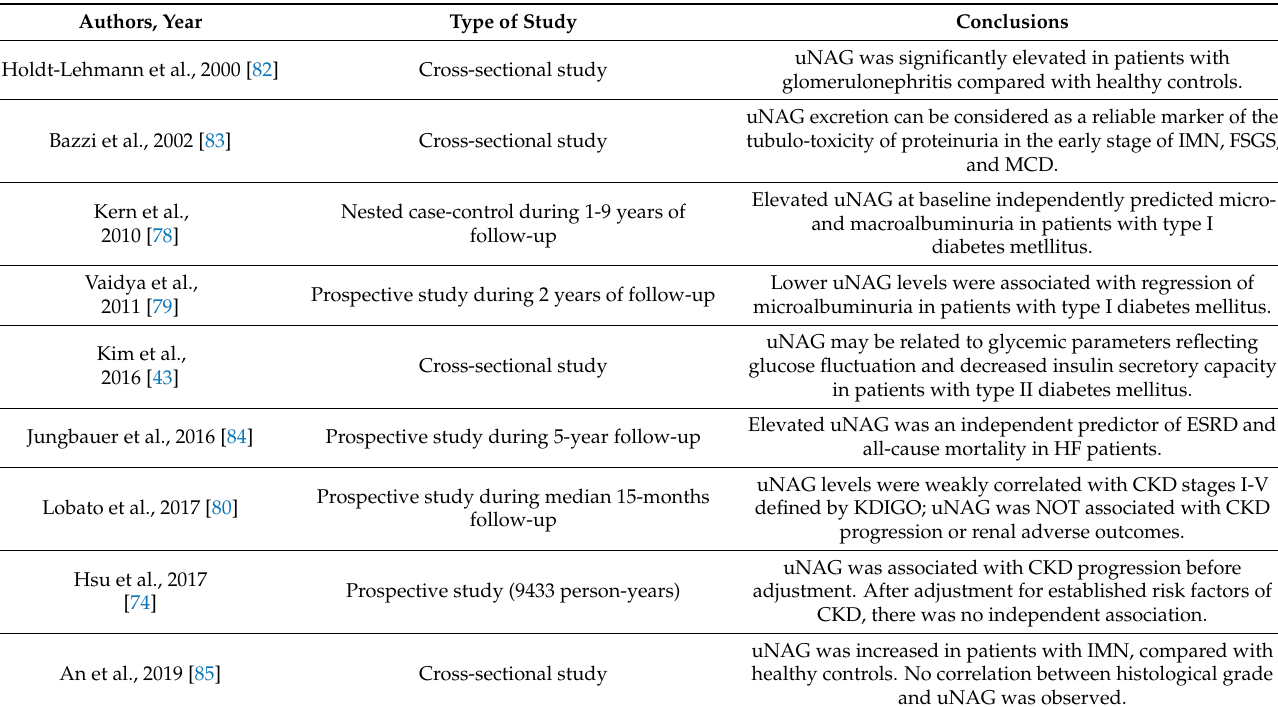
Table 1. Selected overview of the research regarding urinary N-acetyl- β -D-glucosaminidase (uNAG) as a potential predictor of CKD